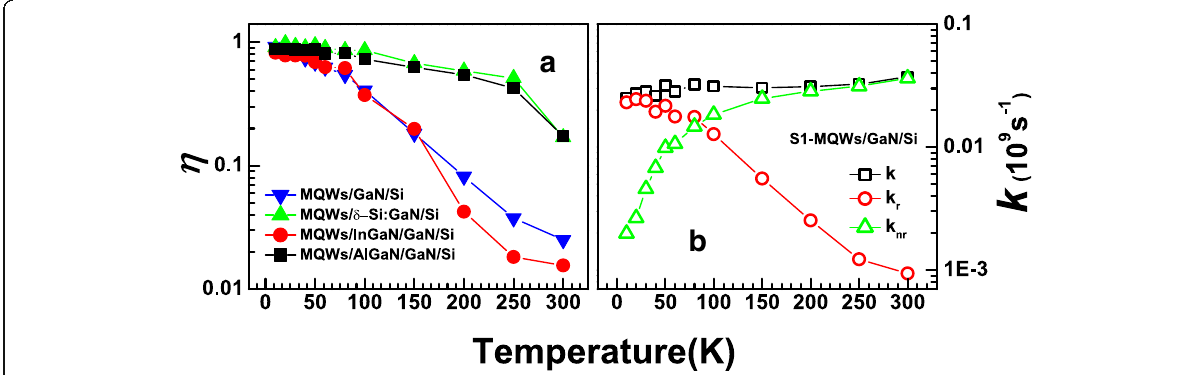
Fig. 5 a Relative PL efficiencies vs. temperature for S1 – S4. The detected wavelength is kept at each peak position according to SSPL results in Fig. 2. b Total recombination rate, radiative recombination rate, and nonradiative recombination rate vs. temperature for